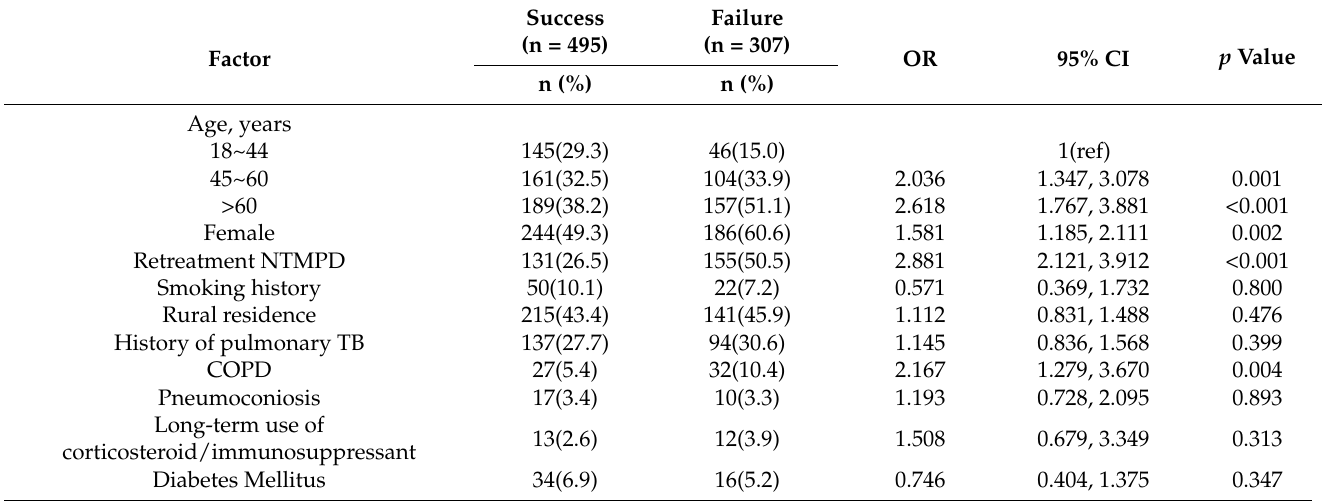
Table 3. Univariate analysis of factors associated with treatment failure in patients with